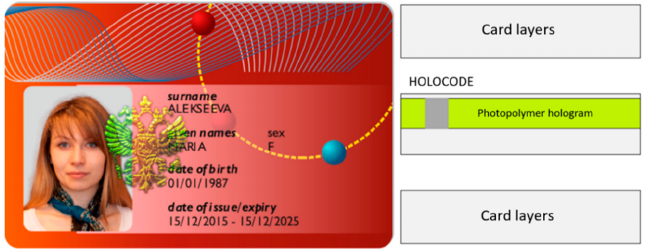
Figure 15. Example of an individualized micro-CGH.